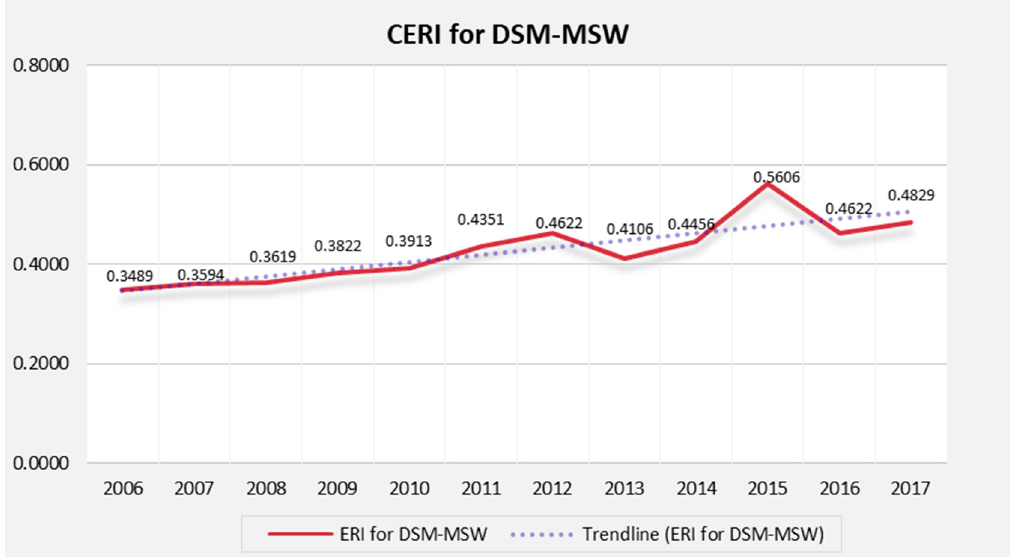
Figure 9. Comprehensive Environmental Risk Index for Dar es Salaam MSW.